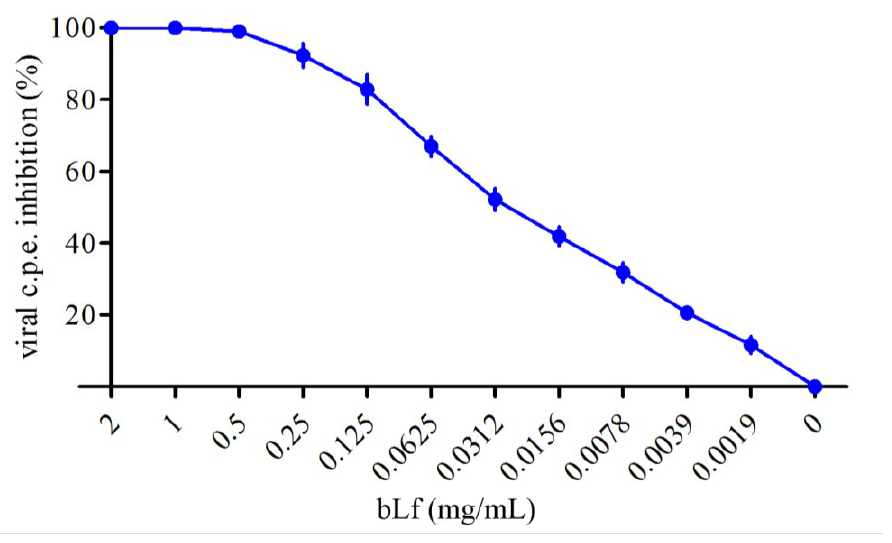
Figure 1. Dose-response curve of bLf toward TosV cytopathic effect in Vero cells. Vero cells were infected with virus (m.o.i. 1). BLf was incubated at different concentrations